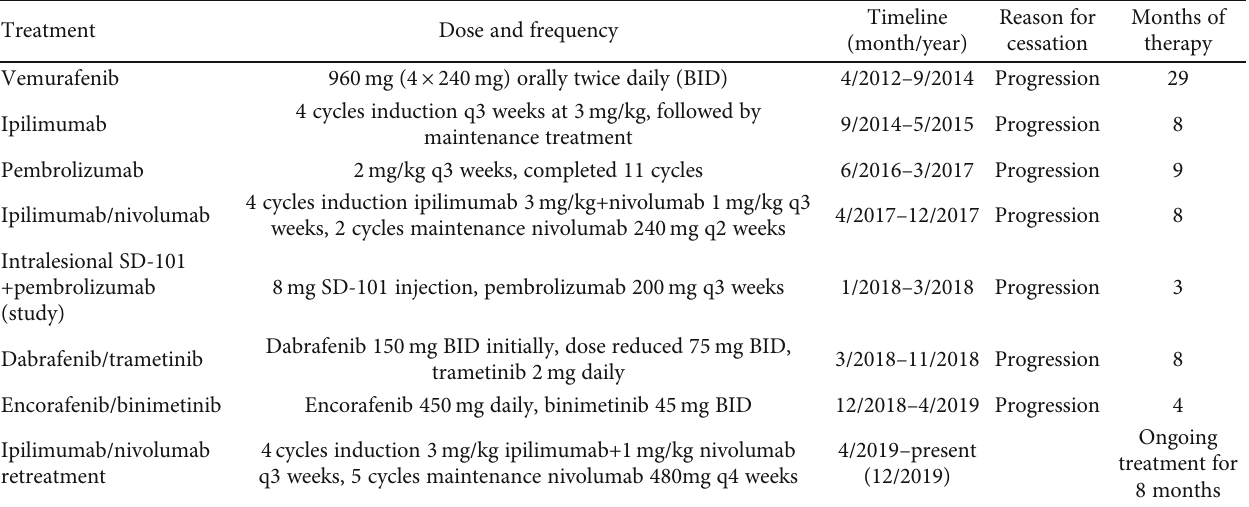
Table 1: Timeline of